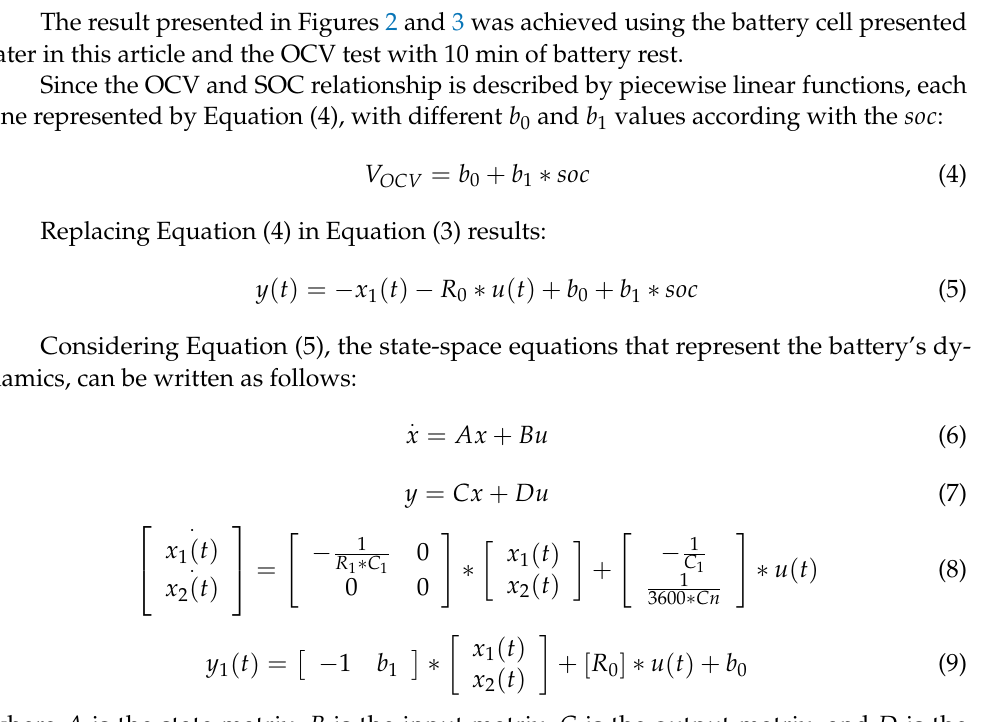
Figure 3. Battery cell hysteresis noticed in the OCV-SOC relationship.